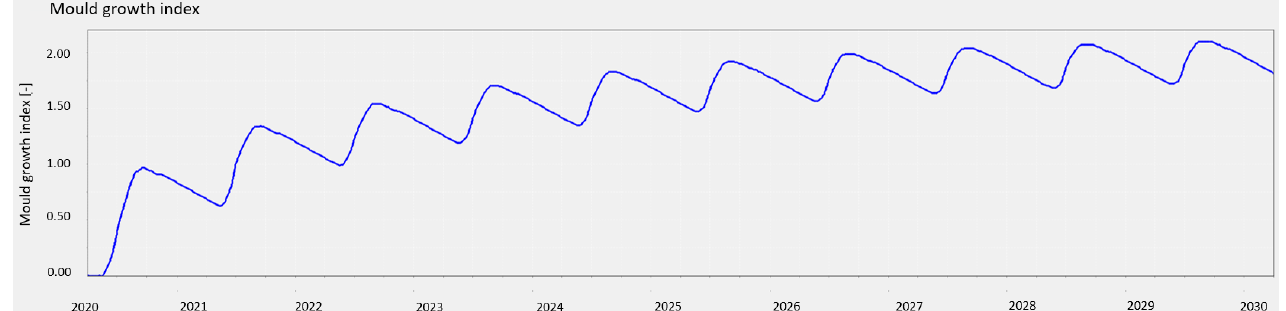
Figure 12. Graph showing mould growth result and mould index for the outside surface of the pli ‐ able membrane within the 40 mm air cavity layer of the 7 ‐ star clay masonry veneer wall with a vapour ‐ permeable membrane—western orientation.